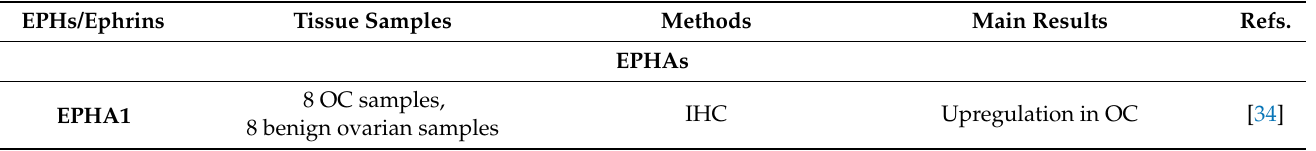
Table 3. The role of the EPH/ephrin system in OC tissue samples. Tissue Samples Methods Main Results